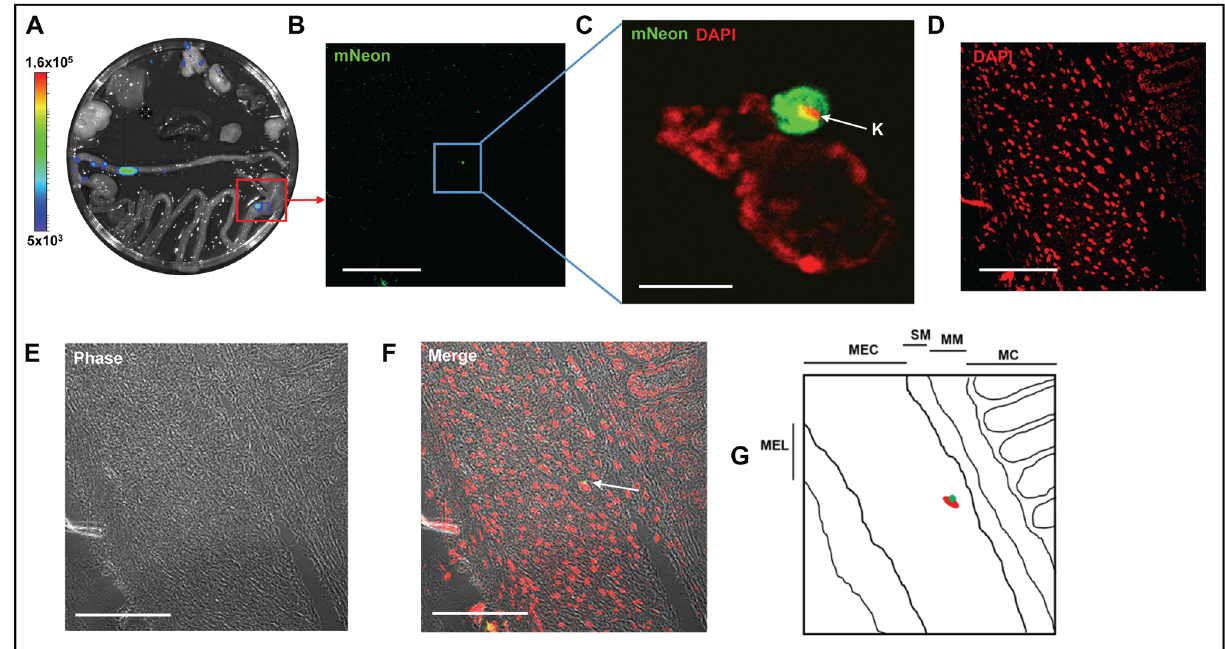
Fig 4. A single amastigotes can be identified in a whole tissue section during chronic stage infections. A. Ex vivo bioluminescence image of organs from a chronically infected mouse (day 117), showing parasite presence in stomach, colon and lungs (organs placed as in Fig 2D). The red box identifies the tissue sample from which the section shown in B-F was taken. B. mNeonGreen fluorescence. C. Higher magnification of boxed area in B, showing a single amastigote in close conjunction with the nucleus of the host cell. The kinetoplast DNA (K) is indicated by an arrow. D. DNA staining of section shown in B. E. Phase image illustrating architecture of tissue section. F. Merged image of B, D and E, showing phase, DNA and mNeonGreen. The single amastigote is indicated by an arrow and appears yellow. For panel C, bar represents 5 μ m; for all other panels, bar indicates 100 μ m. Images B, D, E and F are taken with a 40x objective at 0.7 scan zoom, image C is taken with 100x objective, scan zoom 2.7. G. Schematic indicating individual layers of the section. MC, mucosa; MM, muscularis mucosae; SM, submucosa; MEC, muscularis externae (circular); MEL, muscularis externae (longitudinal). The approximate location of the infected cell is indicated within this schematic (red oval and green